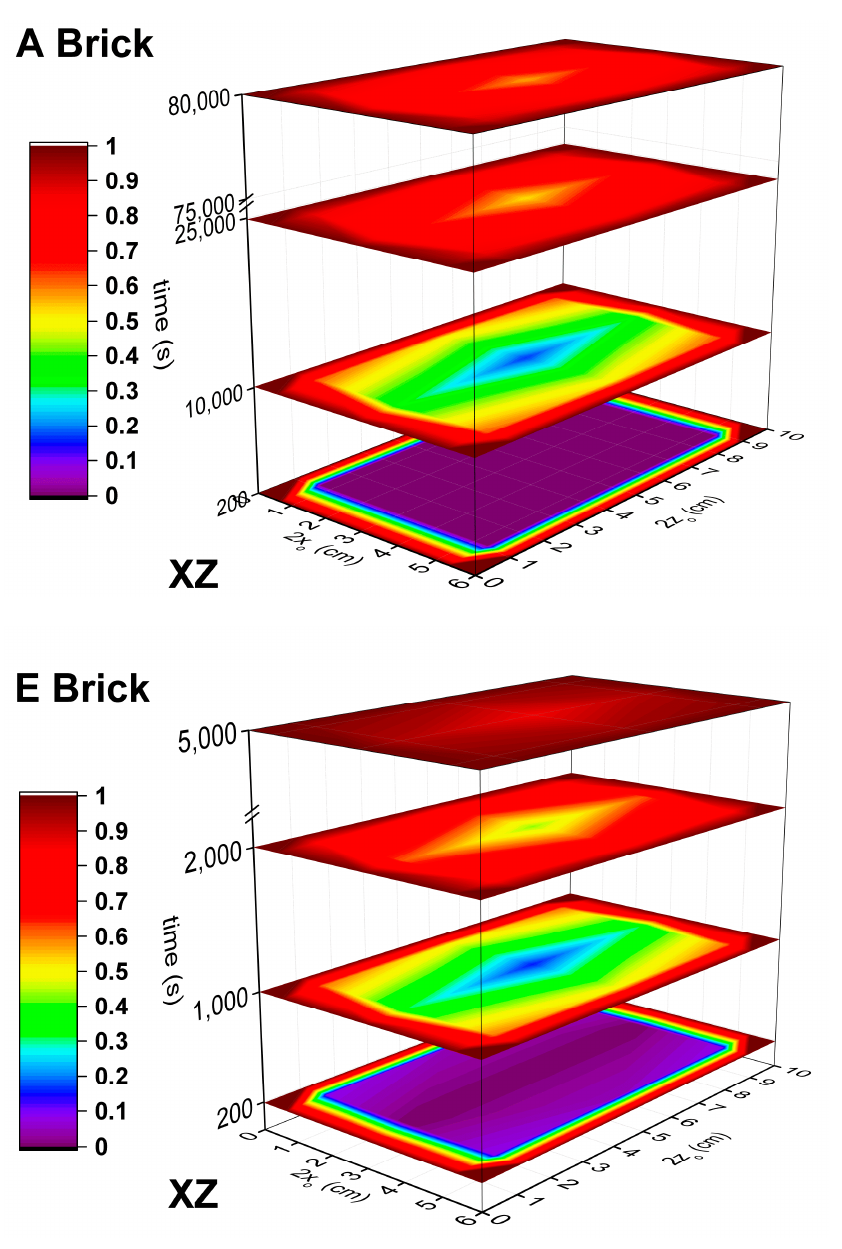
Figure 8. Distribution of the sol concentration through the bricks A and E on the XZ axis.